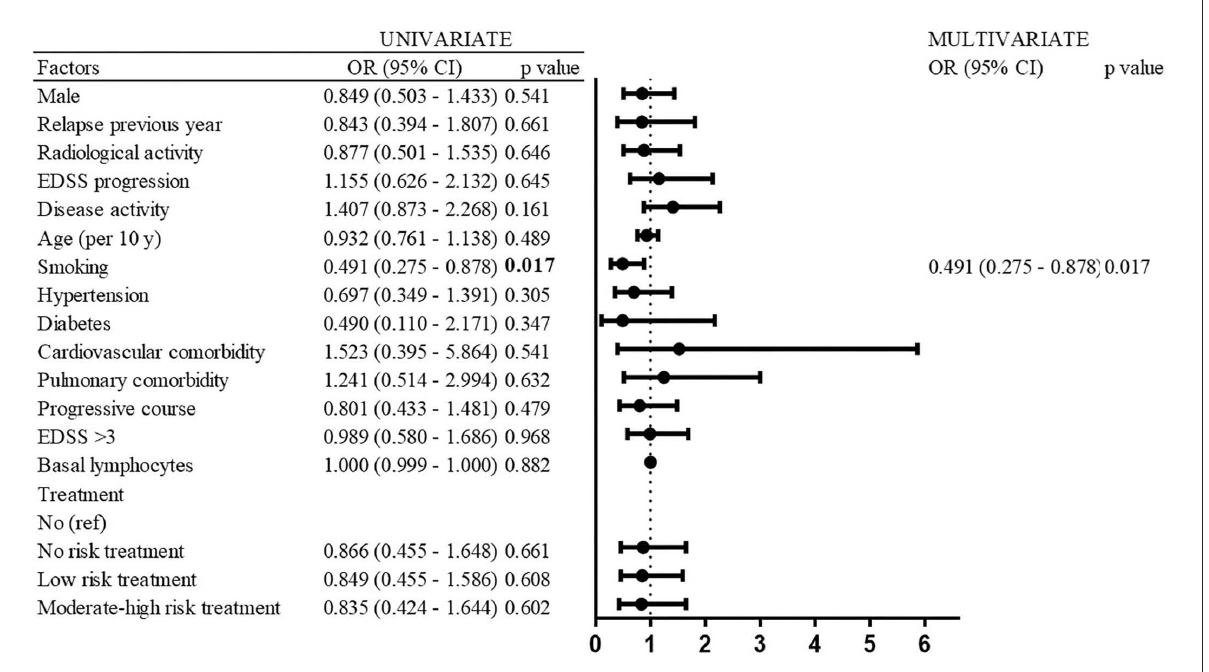
FIGURE4 Risk factors of SARS-CoV-2 infection (univariate and multivariate analyses).